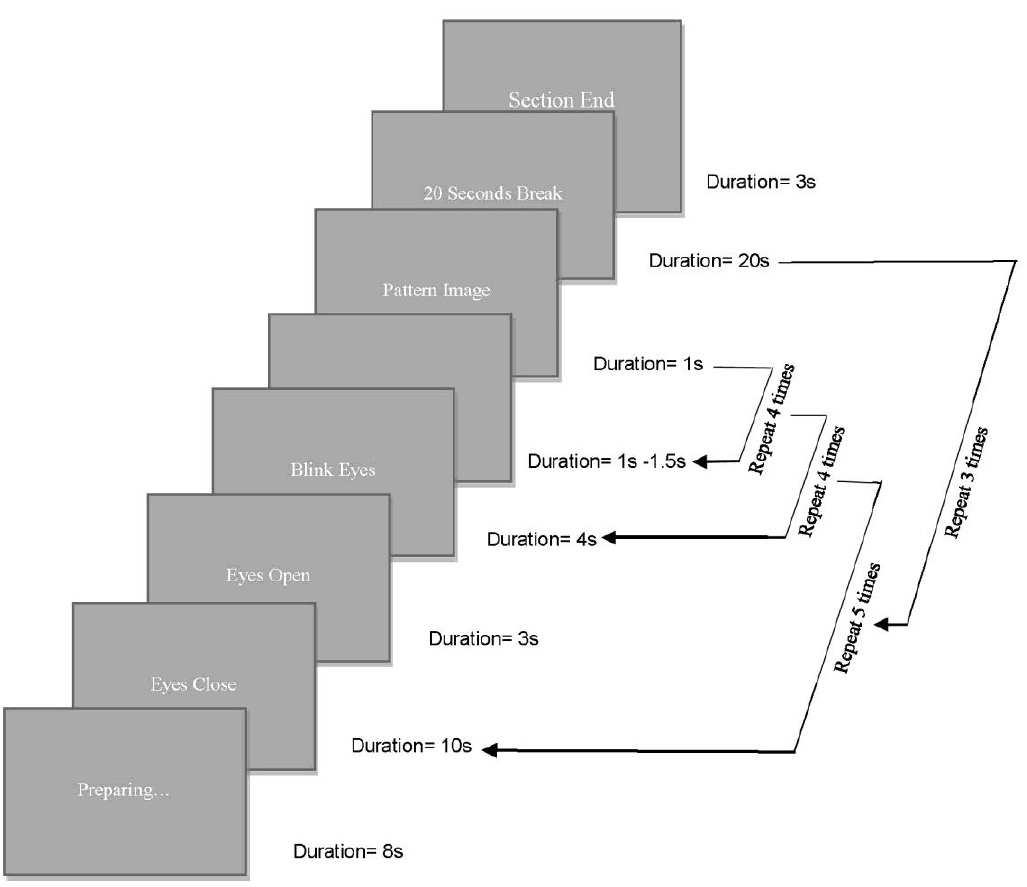
Figure 7. Diagram of the slides with the timing and repeating circles used in the experiment.